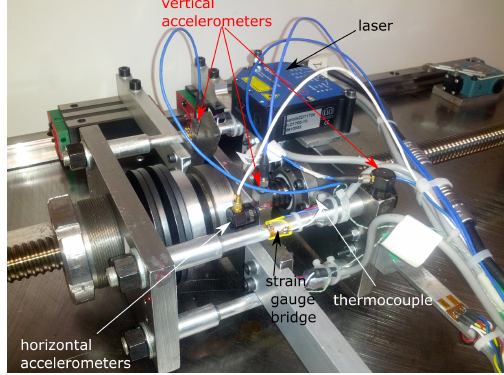
Figure 9. View of the mobile equipments with